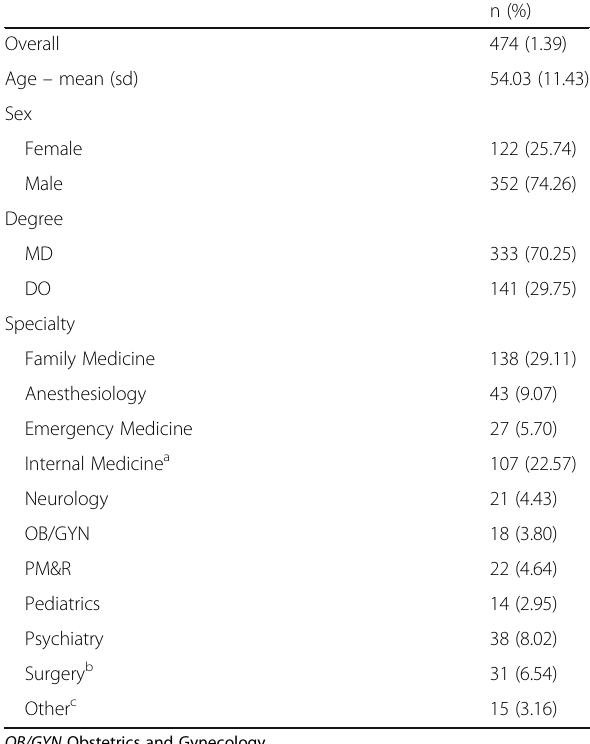
Table 1 Characteristics among all CTR holders in Ohio ( N =